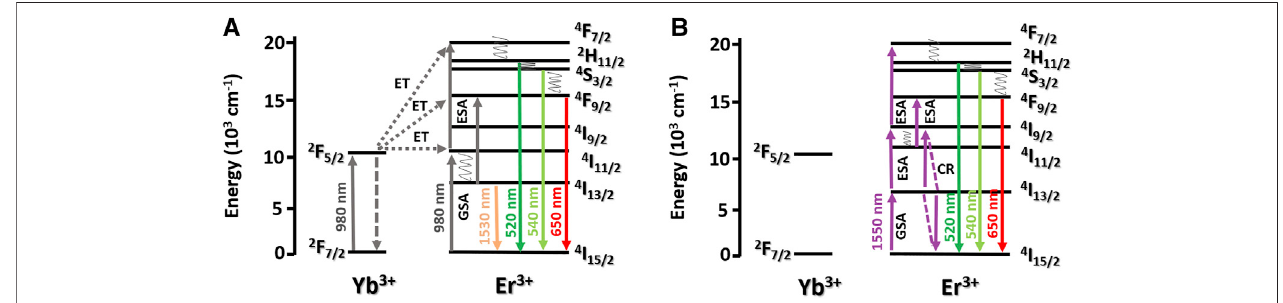
FIGURE6| Simpli fi edenergy-level diagram oftheEr 3+ and Yb 3+ ionsand the proposed mechanisms, under excitationsat 980 (A) and 1,550 nm (B) . Upward and downwards solid arrows indicate photon absorption and emission, respectively. Dashed arrows stand for cross-relaxation processes.